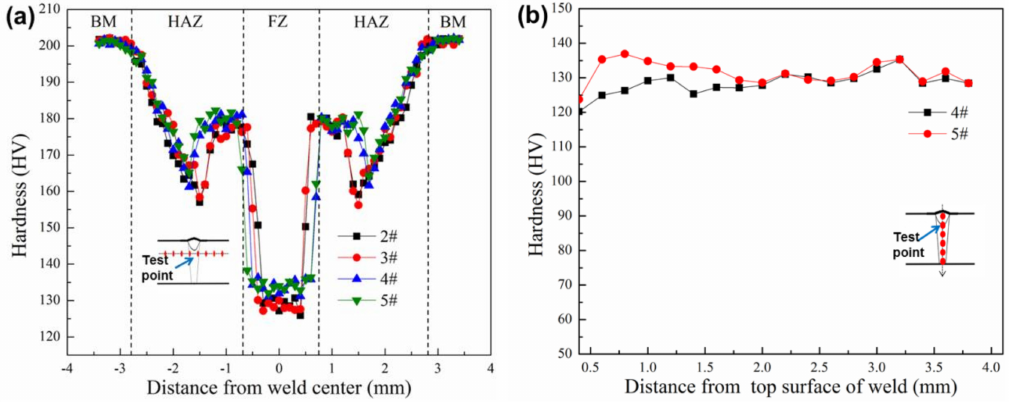
Figure 7. Microhardness distribution of welded joints: ( a ) perpendicular to the weld center and ( b ) parallel to the weld